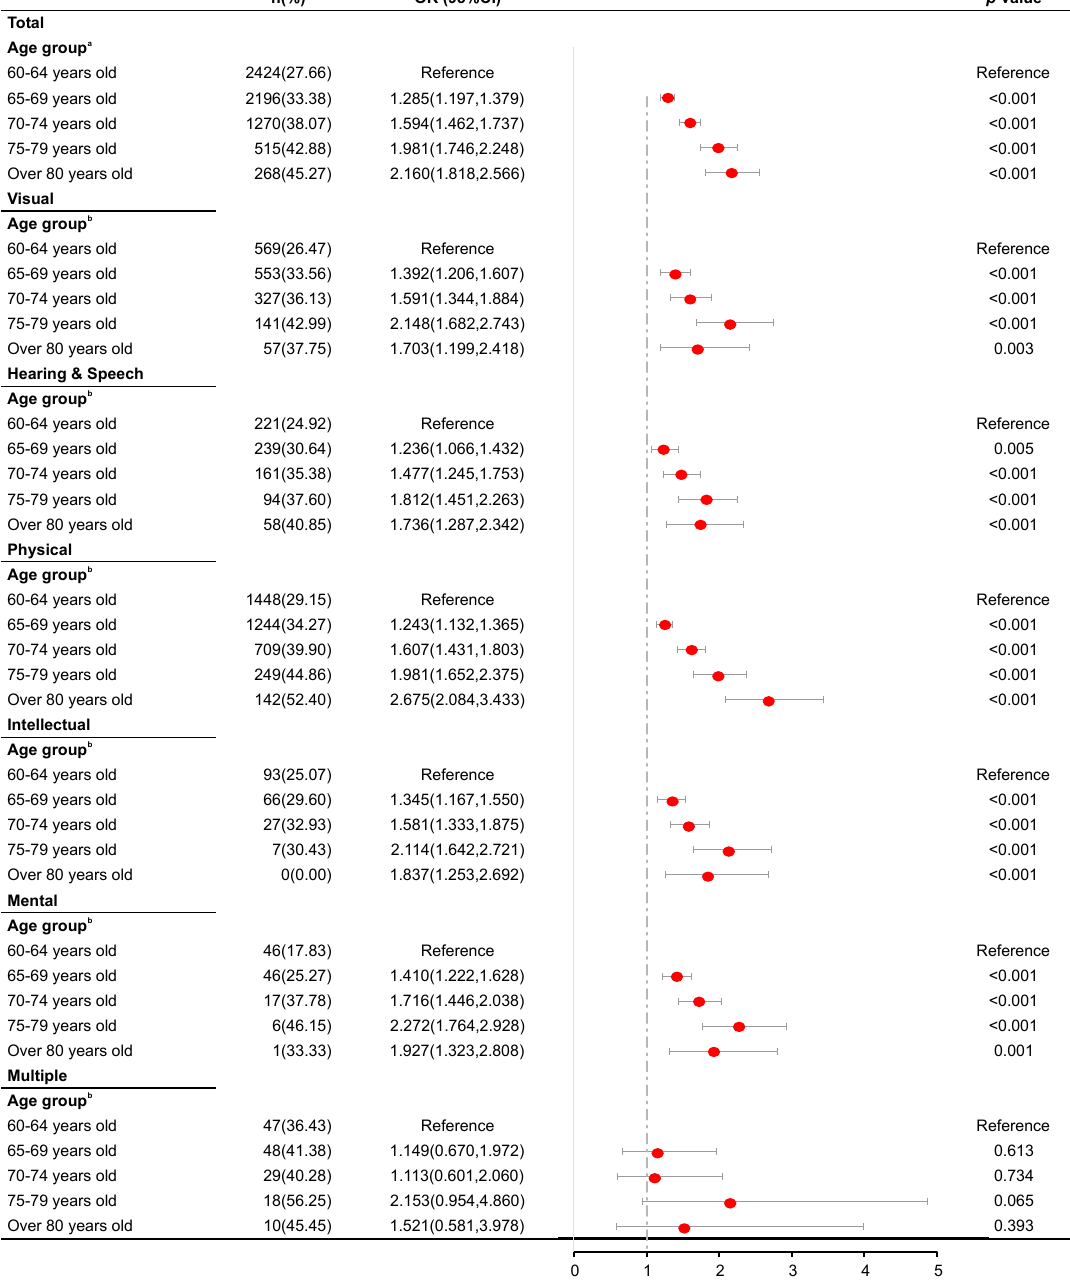
Figure 1. Results of a logistic regression analysis of hypertension according to age group across disability types. a Adjusted for sex, residence permit, education level, marital status, disability type, and disability severity. b Adjusted for sex, residence permit, education level, marital status, and disability severity.